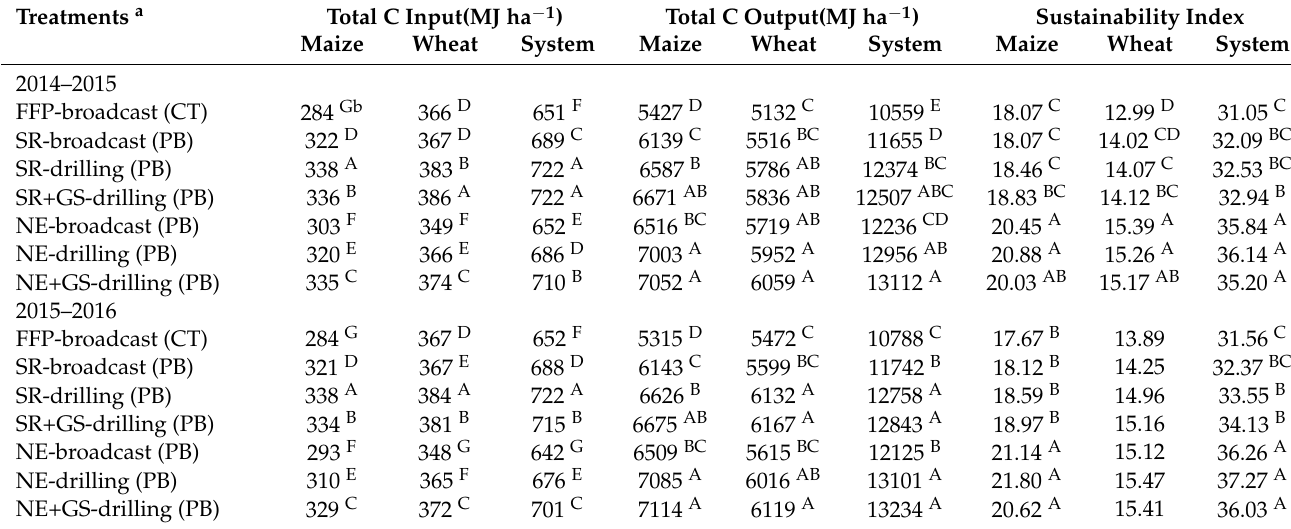
a Refer Table 2 for details of nutrient management treatments. b Means within different nutrient management strategies by different letters are significantly different from one another based on LSD